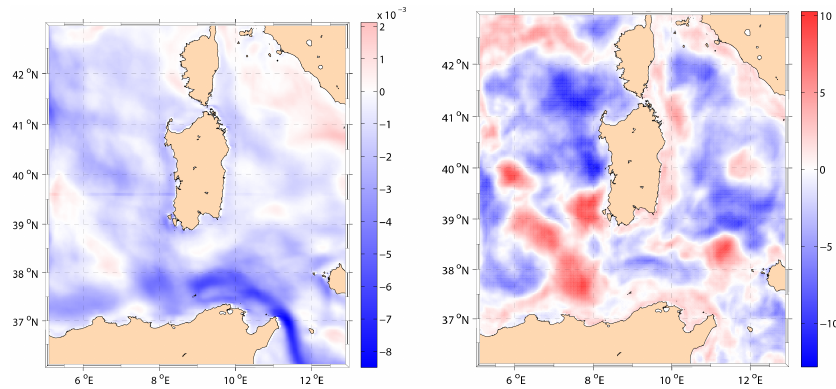
Figure 5. Difference map (BFC-BF) of the time-averaged wind stress (left) and net heat fluxes (right). Blue values indicate a BFC stress/heat lower than BF. Units are Nm − 2 and Wm − 2 respectively.